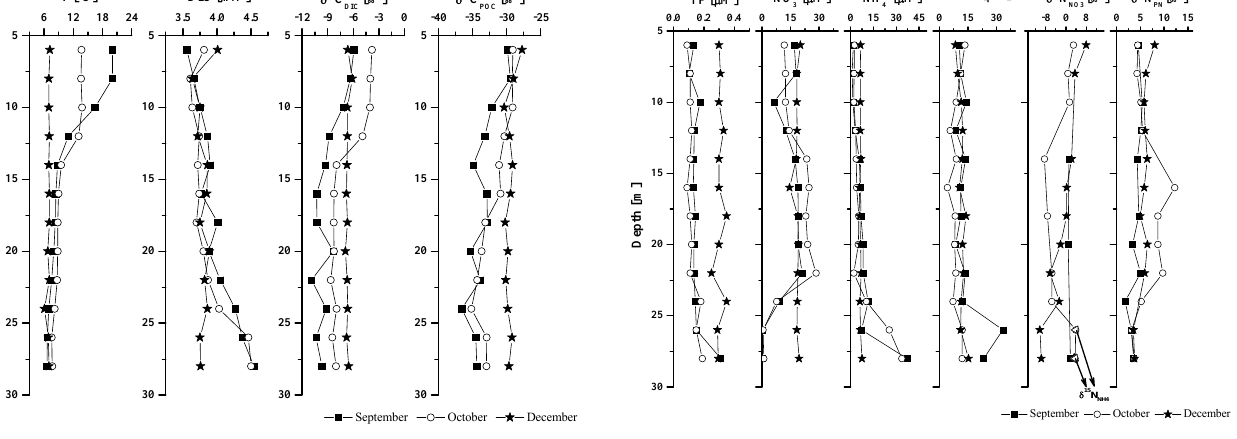
the water column, while in December PO 3 − concentrations 4 were larger. The vertical profiles for NO − concentration 3 were very similar in September and October, reaching max- imum concentrations of 21.1 µM and 28.4 µM, respectively at a depth of 22 m. Average concentrations of 13.4 ± 5.3 µM and 12.6 ± 1.1 µM were observed above the thermocline and 17.3 ± 4.3 and 21.9 ± 7.2 µM below it in September and Oc- tober, respectively. The lowest NO − concentrations were 3 concentrations, observed in parallel with the highest NH + 4 which were 37 µM in September and 33 µM in October at the bottom of the water column. In December, NO − concen- 3 trations exhibited little variation, with an average value of 18.7 ± 1.3 µM throughout the water column. The NH + con- 4 centrations were low in the upper part of the column, with av- erage concentrations of 4.72 ± 0.81 µM and 3.37 ± 0.58 M in September and October, but increased below 24 m. The av- erage NH + concentration in December was 6.48 ± 0.43 4